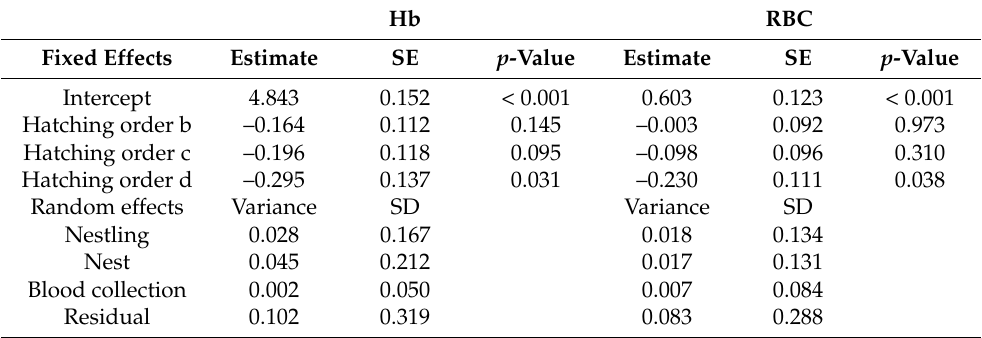
Table 2. Estimated model coefficients for the LMM model of Hb (haemoglobin) level and RBC (red blood cell) count in the blood of free-living marsh harrier nestlings. The hatching order of the nestlings is indicated by letters ( b , c , and d ). Standard errors (SE) and p -values are shown for the fixed effects. The values of the random effects are variance estimates and their standard deviations (SD). Hb RBC